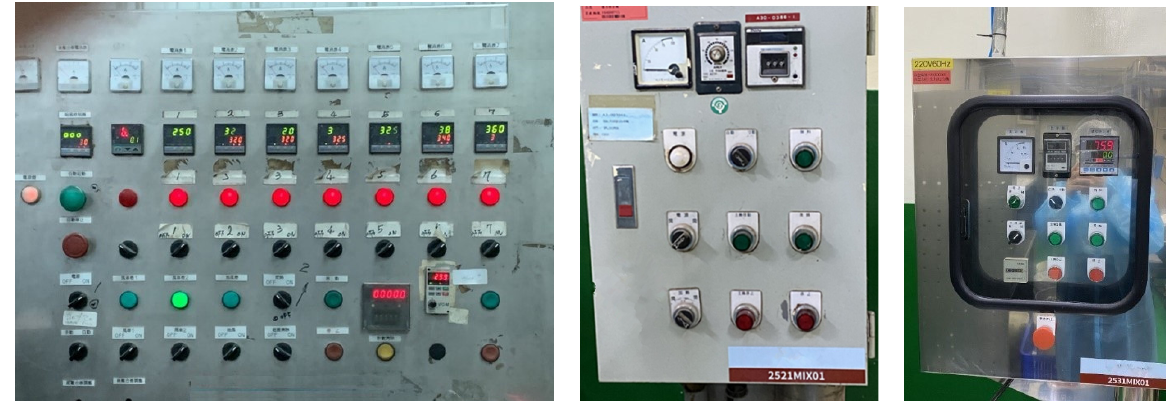
Figure 1. Plastic injection machines.